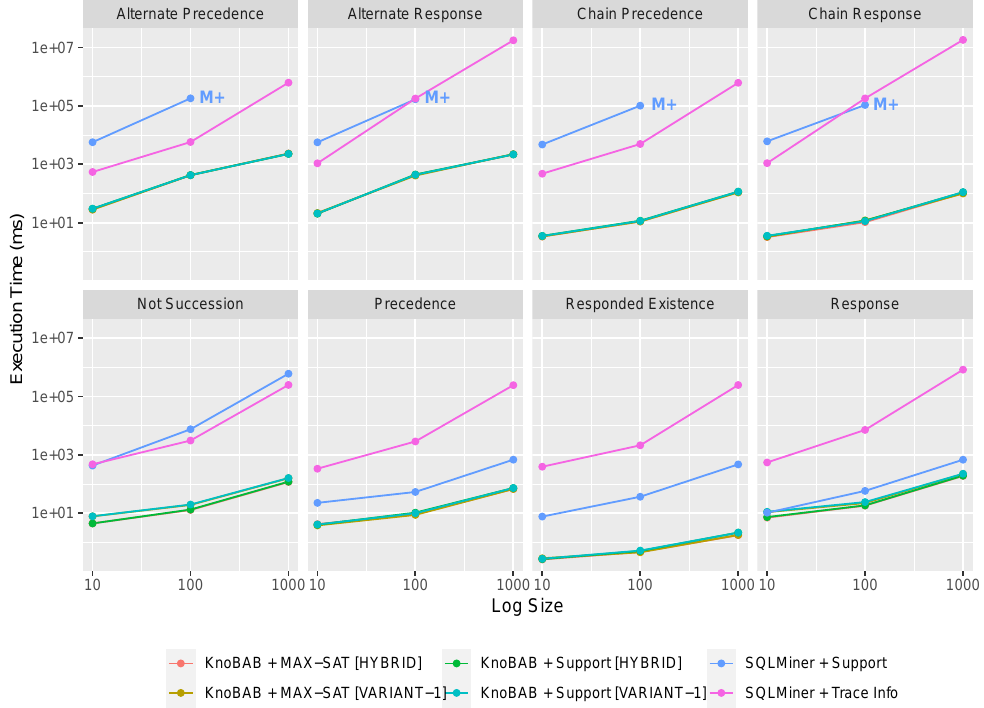
Figure 11. Results for relational temporal mining Section